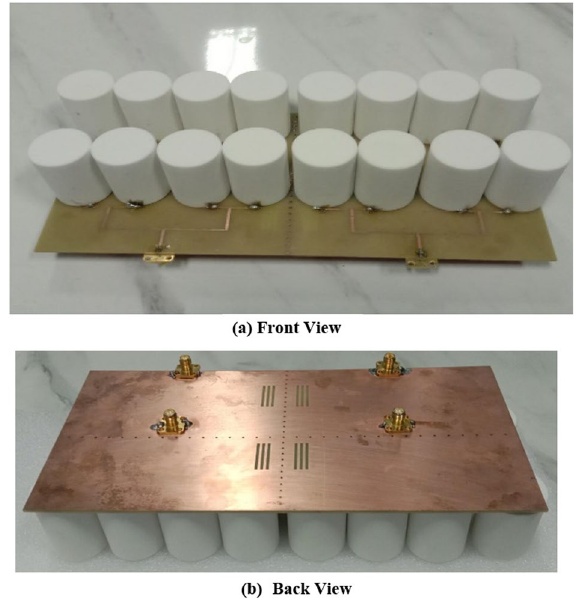
Fig. 10 Fabrication antenna massive MIMO 4